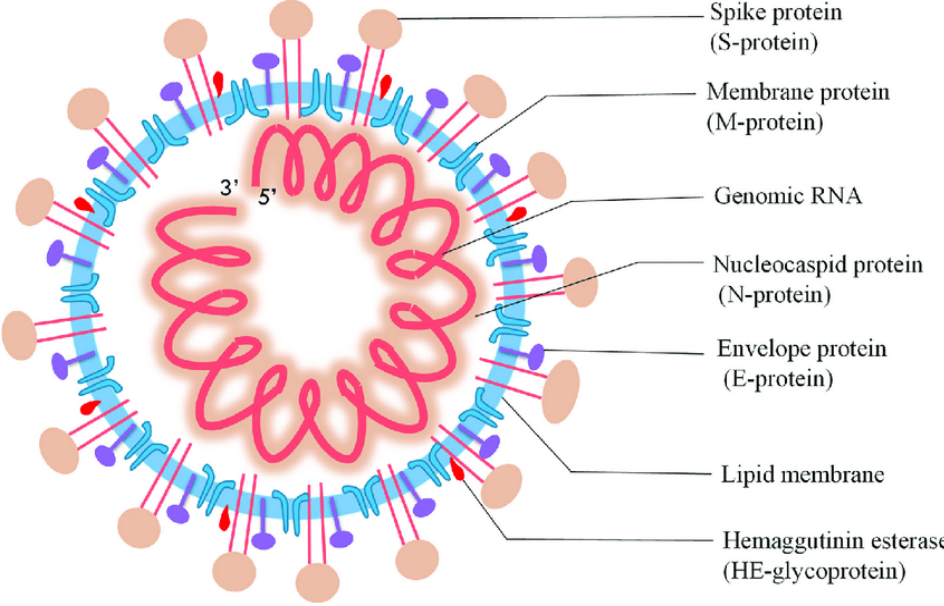
Figure 1. Diagrammatic representation of SARS-CoV-2 (reproduced with permission from Jalandra, R. et al., 2020, 129, 110446 [4]).